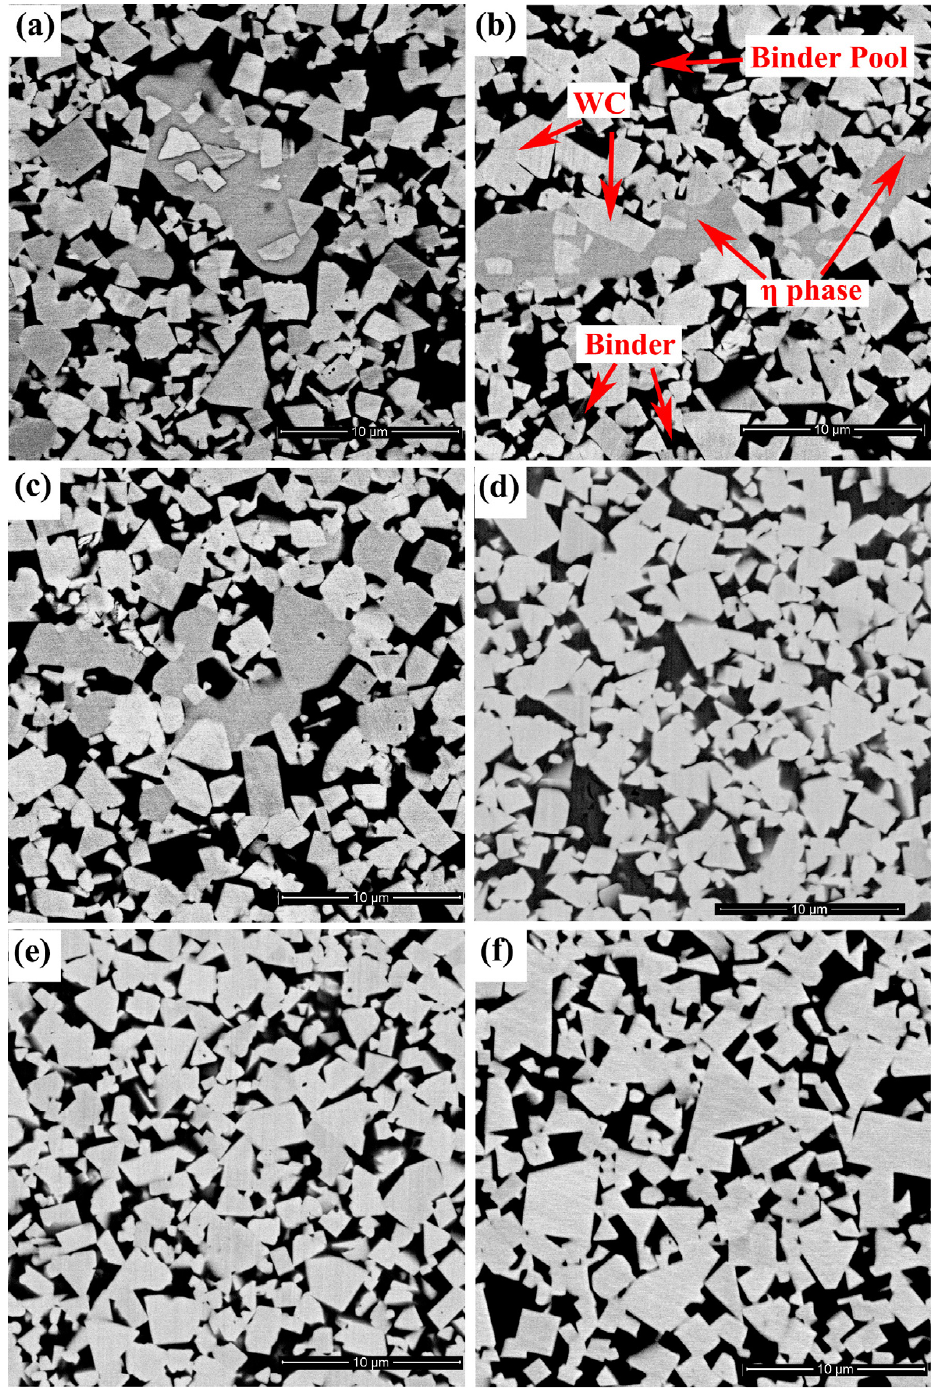
Figure 2. Microstructure of WC ‐ 10Co ‐ 8Ni ‐ 1Fe ‐ 1Cr: ( a ) Alloy 1, ( b ) Alloy 2, ( c ) Alloy 3, ( d ) Alloy 4 and ( e ) Alloy 5; microstructure of WC ‐ Co ( f ).